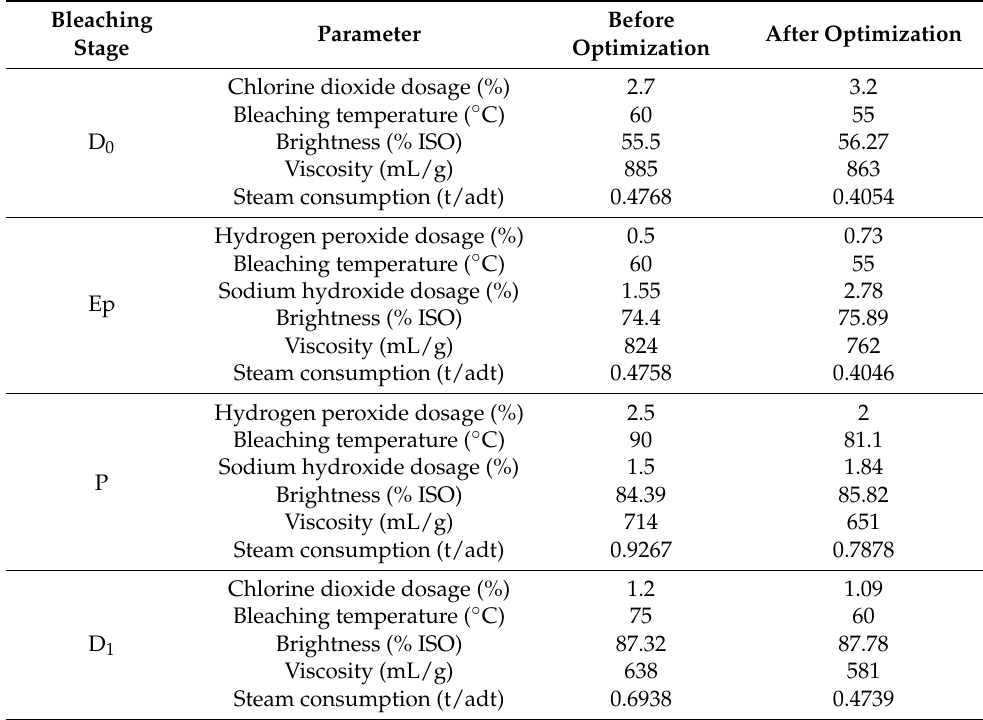
Table 4. Operating condition comparison before and after optimization.